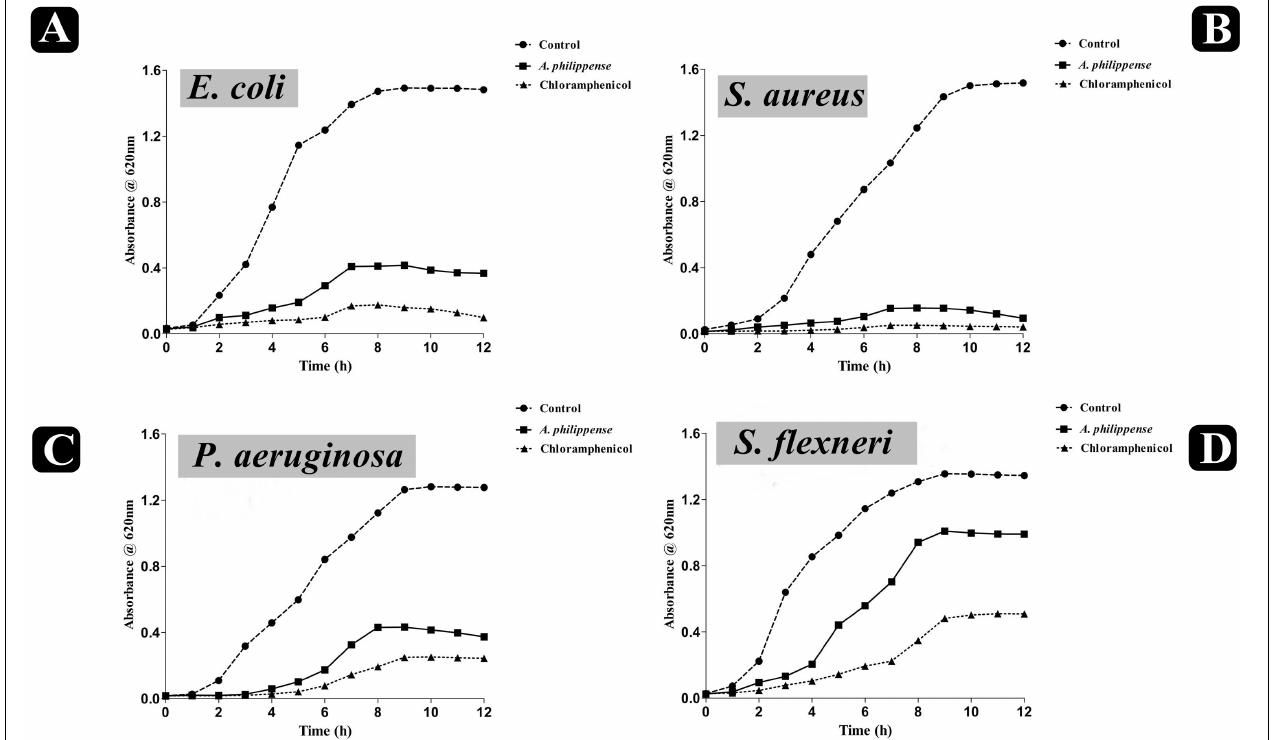
FIGURE 2 | Growth curve analysis of bacteria. (A) Growth curve pattern of E. coli , with and without plant extract; (B) growth curve pattern of S. aureus , with and without plant extract; (C) growth curve pattern of P. aeruginosa , with and without plant extract; and (D) growth curve pattern of S. flexneri , with and without plant extract. Chloramphenicol was used as positive